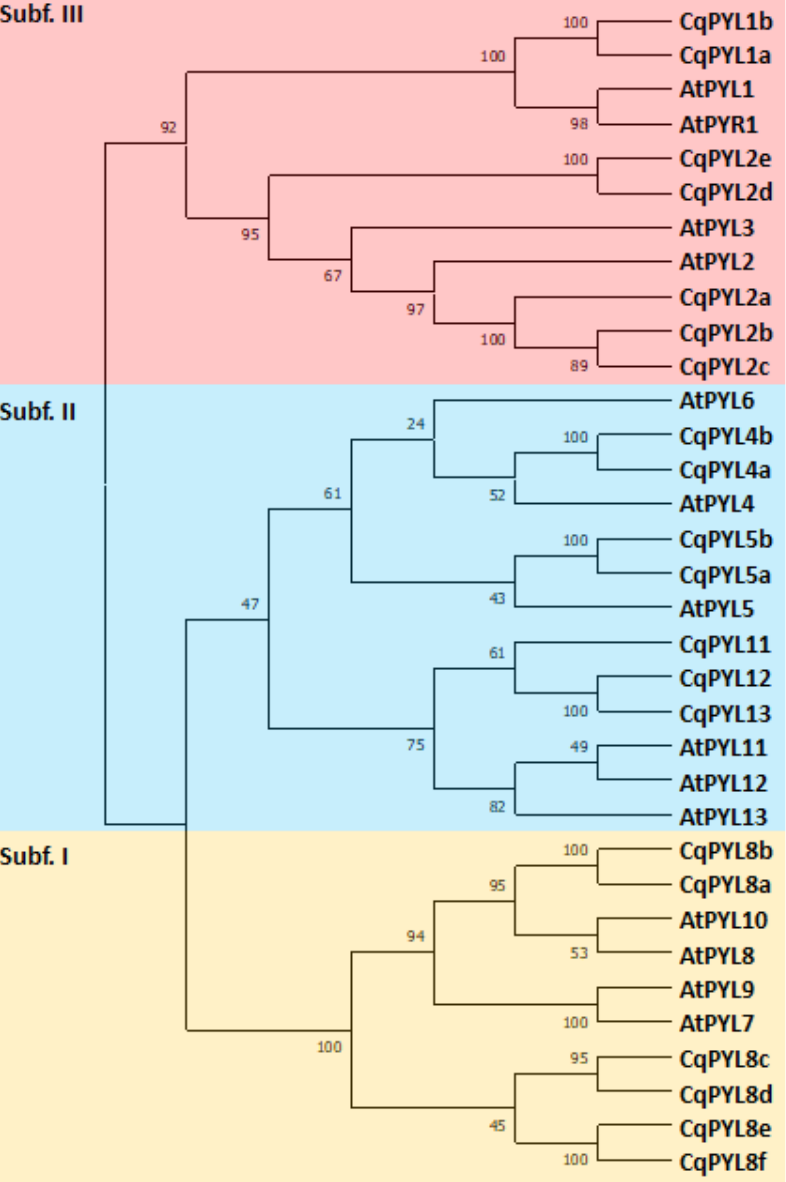
Figure 2. Phylogenetic analysis of PYL gene family in Chenopodium quinoa and arabidopsis thaliana . Tree was constructed by MEGAx using maximum-likelihood method with 1000 bootstraps. Orange, blue and red clades represent subfamilies I, II and III, respectively. The percentage of replicate trees in which the associated taxa clustered together in the bootstrap test (1000 replicates) are shown next to the